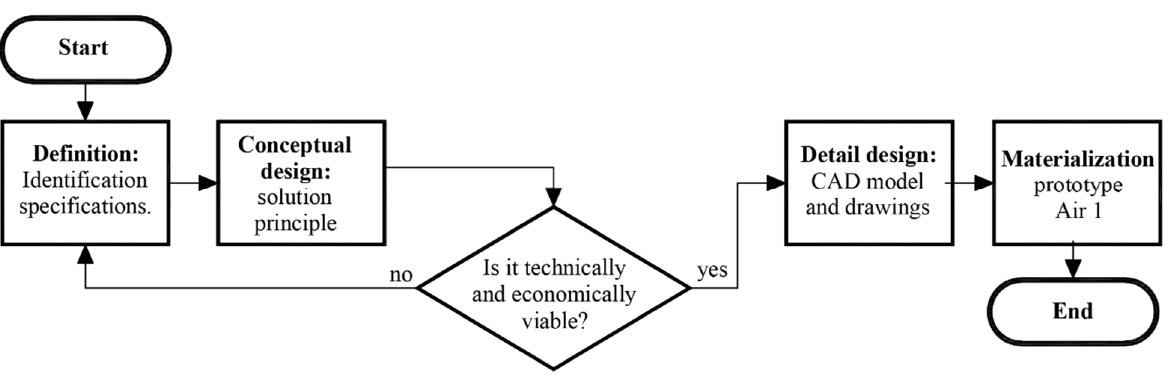
Figure 1. Conceptual flowchart of the design process.